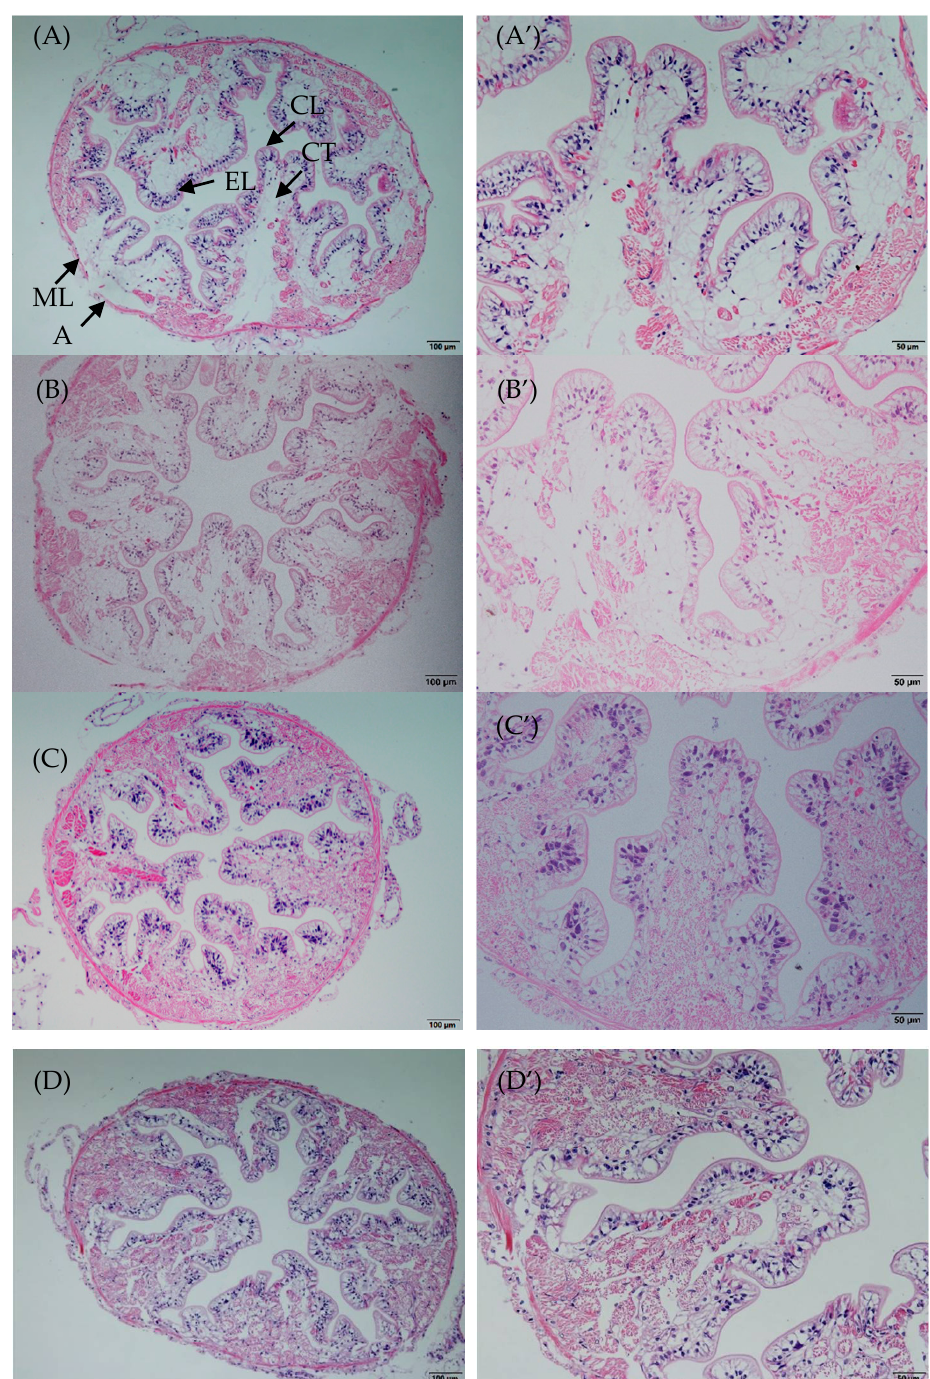
Figure 1. Intestinal morphology analysis of crayfish fed with different experimental diets for 14 days and 28 days. ( A ) control group after 14 days of feeding (( A ): 100×, ( A’ ): 50×); ( B ) control group after 28 days of feeding (( B ): 100×, ( B’ ): 50×); ( C ) treatment group ( S. cerevisiae at 10 7 CFU/g diet) after 14 days of feeding (( C ): 100×, ( C’ ): 50×); ( D ) treatment group ( S. cerevisiae at 10 7 CFU/g diet) after 28 days of feeding (( D ): 100×, ( D’ ): 50×). CL: chitinous layer; EL: epithelial layer; CT: connective tissue layer; ML: muscle layer; A: adventitia.